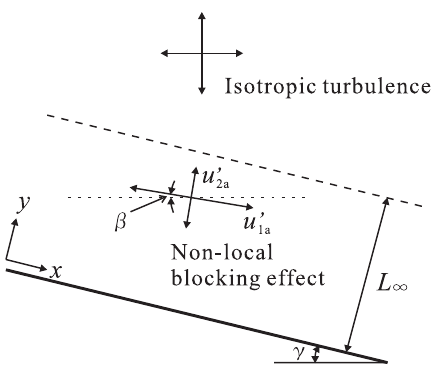
Fig. 2 Local analysis of blocking e ff